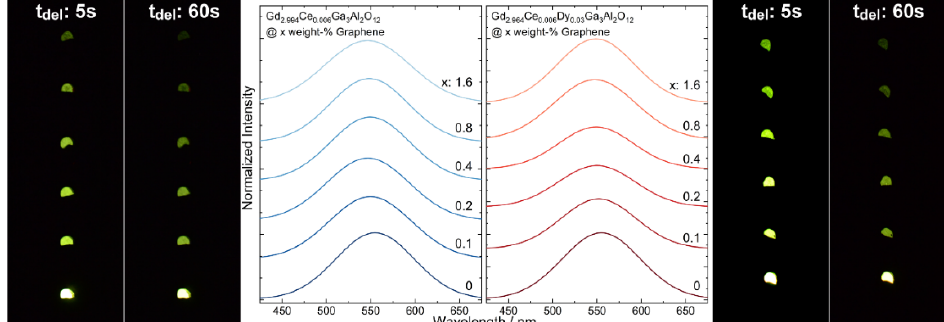
Figure 6. Persistent luminescence spectra taken seconds after ceasing 445 nm irradiation and photo of Gd 2.994 Ce 0.006 Ga 3 Al 2 O 12 and Gd 2.964 Ce 0.006 Dy 0.03 Ga 3 Al 2 O 12 ceramics with different graphene content. Table 2. The maximum intensity position of persistent luminescence spectra and their FWHM registered for Gd 2.994 Ce 0.006 Ga 3 Al 2 O 12 and Gd 2.964 Ce 0.006 Dy 0.03 Ga 3 Al 2 O 12 ceramics with different graphene content.